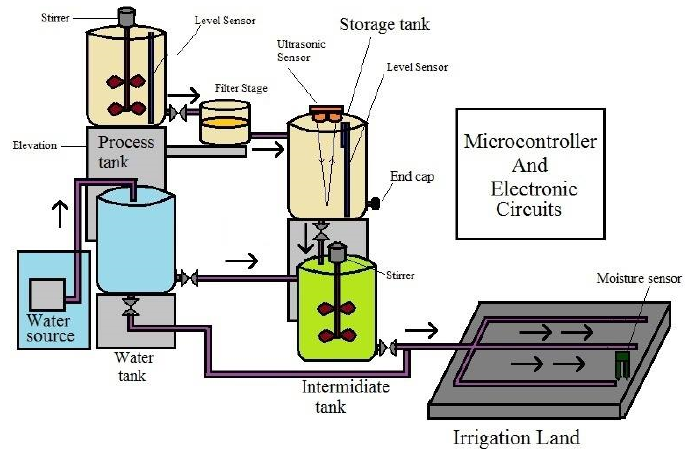
Figure 2. Block diagram of the designed system.